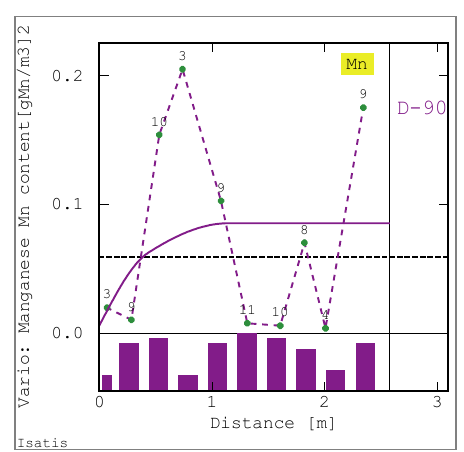
Fig. 20. Directional semivariogram (D-90)